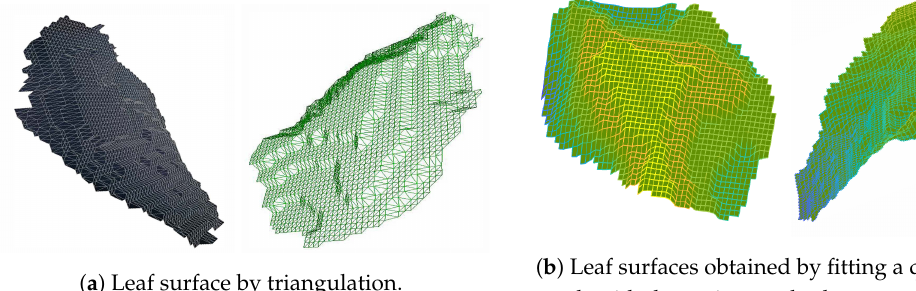
Figure 7. Examples of leaves surface geometry as obtained from the estimation process described in the